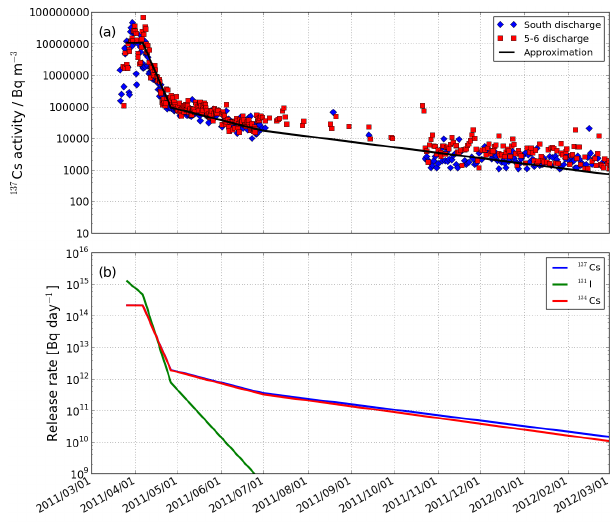
Fig. 3. (a) 137 Cs activity (Bqm − 3 ) at the 5–6 and south discharge canals near the 1F NPP site. Gray line is the exponential curve fit to the 137 Cs activity at both canals. (b) Estimated direct release rates (Bqday − 1 ) of 131 I, 134 Cs, and 137 Cs from the 1F